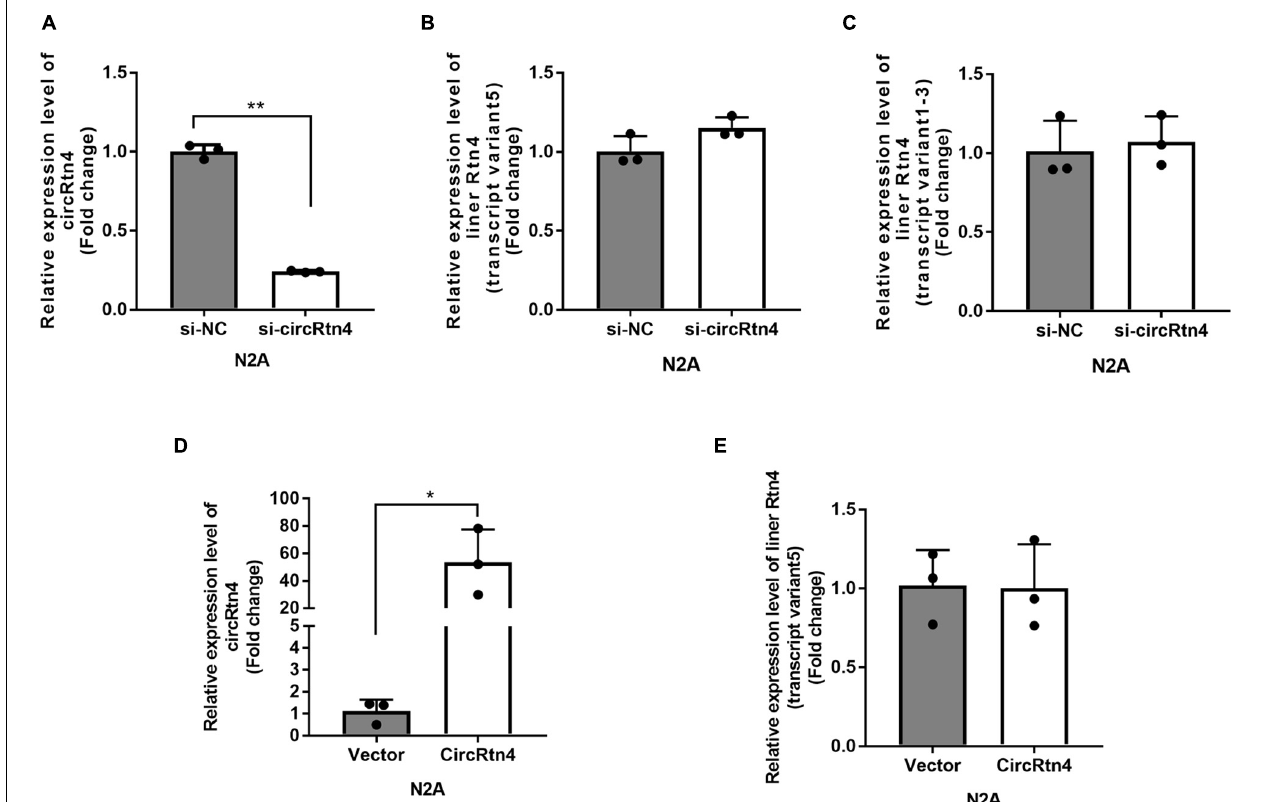
FIGURE 2 | The efficiency of circRtn4 knockdown and overexpression. (A) The knockdown efficiency of circRtn4 was determined by qRT-PCR. (B,C) After transfection of circRtn4 siRNA, the expression levels of Rtn4 variants were detected by qRT-PCR. The results were shown as the mean ± SD ( n = 3). (D) The overexpression efficiency of circRtn4 was determined by qRT-PCR. (E) After transfection of overexpressing vector, the expression levels of Rtn4 variant 5 were detected by qRT-PCR. The results were shown as the mean ± SD (* p < 0.05, and ** p < 0.01 n = 3).